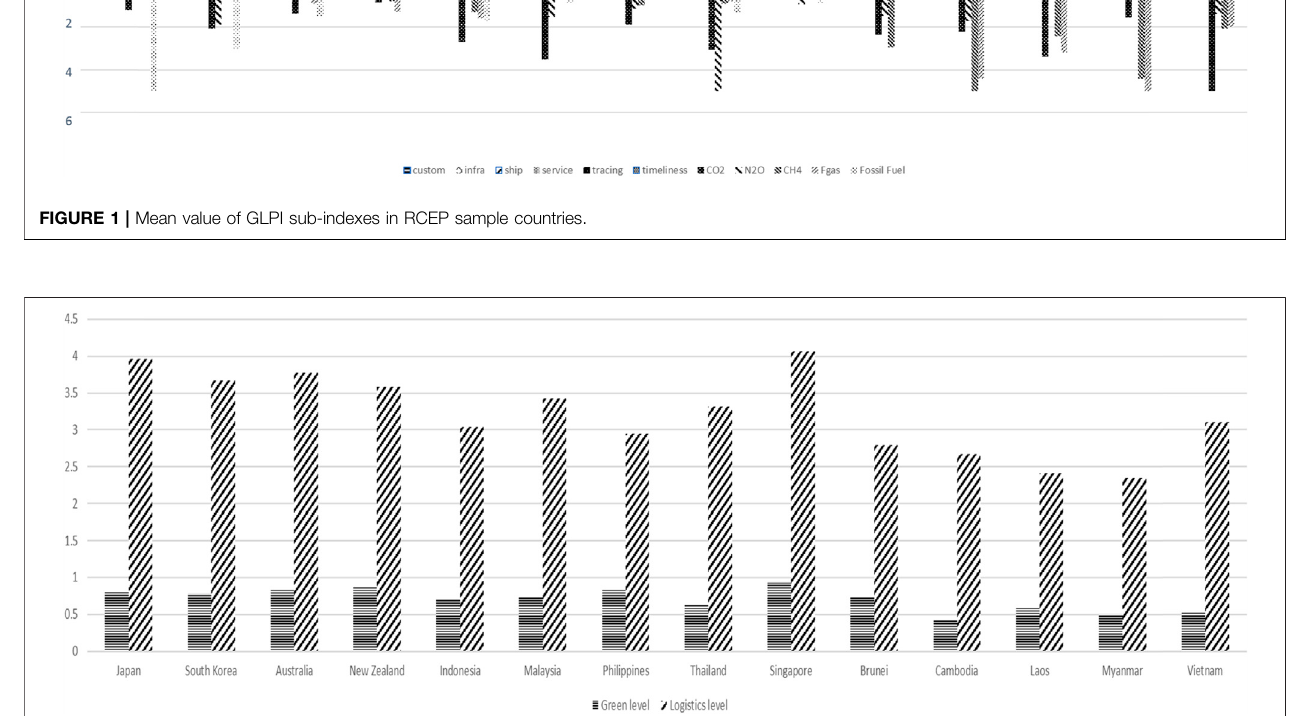
FIGURE 2 | Mean green level and logistics level of RCEP sample